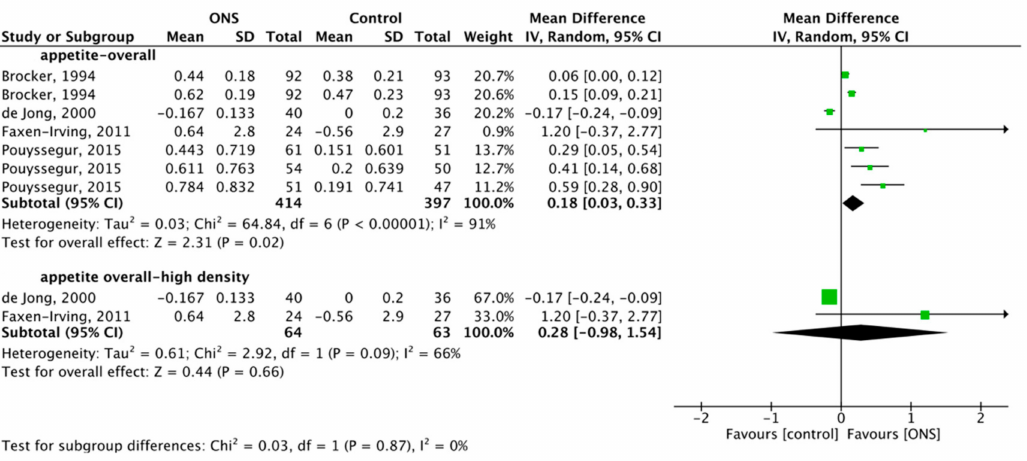
Figure 4. Forest plot comparing the effect of ONS on overall appetite and subgroup